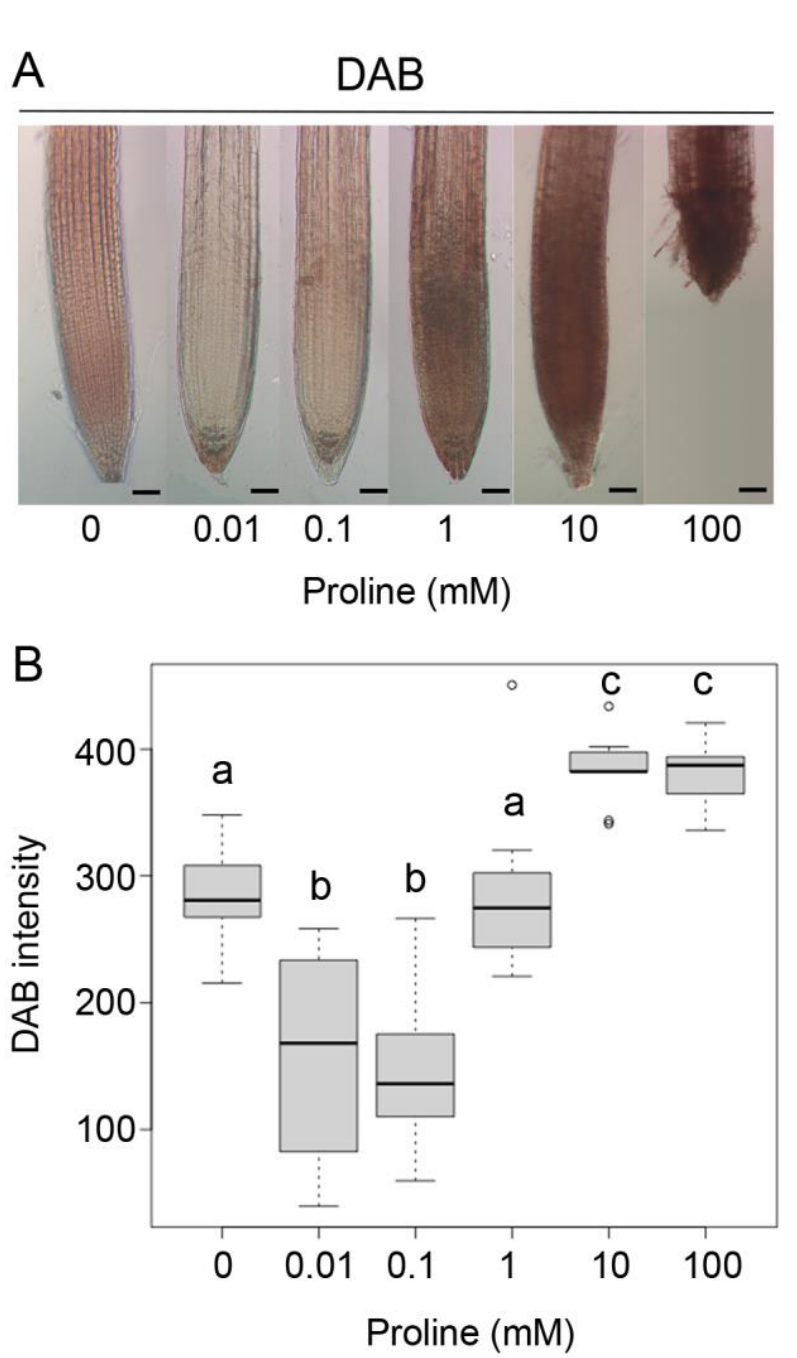
Figure 4. Effect of exogenous proline supplementation on H 2 O 2 accumulation. ( A ) Wildtype roots were grown for 7 days in vertical plates supplemented with increasing proline concentrations and stained with DAB. Only weak staining is detectable at micromolar proline concentrations, while more intense staining is visible at higher, millimolar concentrations. H 2 O 2 concentrations above 10 mM, were highly toxic to Arabidopsis plantlets, which hardly germinate and grow. Bars: (0–10) = 50 µ m; (100) = 20 µ M. ( B ) Boxplot representation of the intensity of DAB staining of apical roots from the root cap to the elongation/transition zone. A one-way ANOVA followed by a Tukey post-hoc test identified three groups significantly different ( p < 0.01 between a–b, and a–c; p < 0.001 between b–c). Different letters indicate significant differences among groups. The means represent the average of a minimum of ten samples from three independent experiments replicated at least three